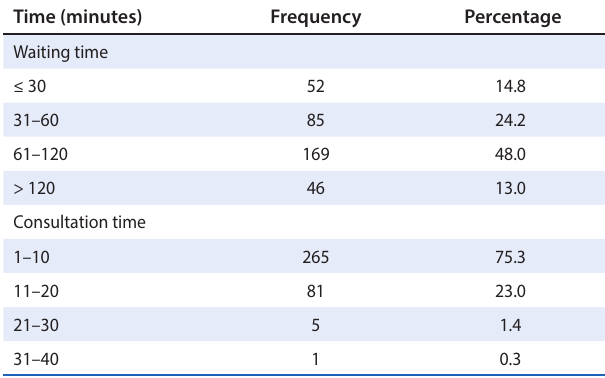
Table 5: The different waiting